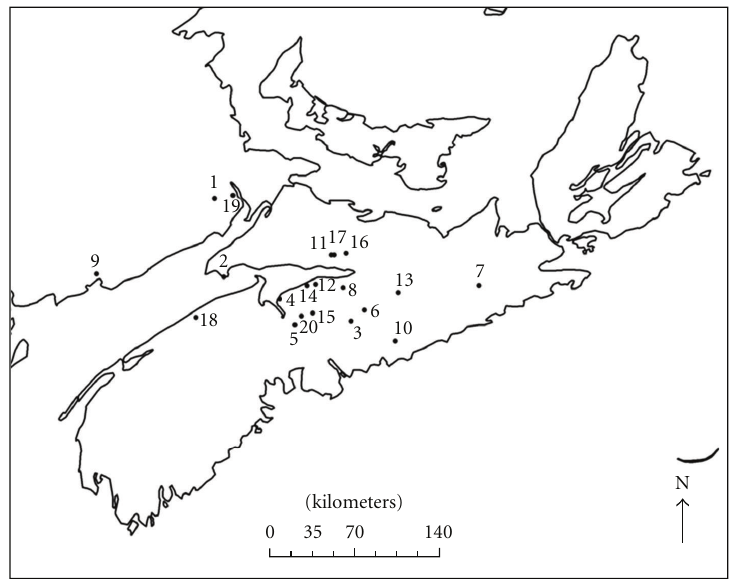
Figure 1: Capture sites in Nova Scotia and New Brunswick used for ectoparasite sampling from August–October, 2010. Numbers correspond with sites in Table